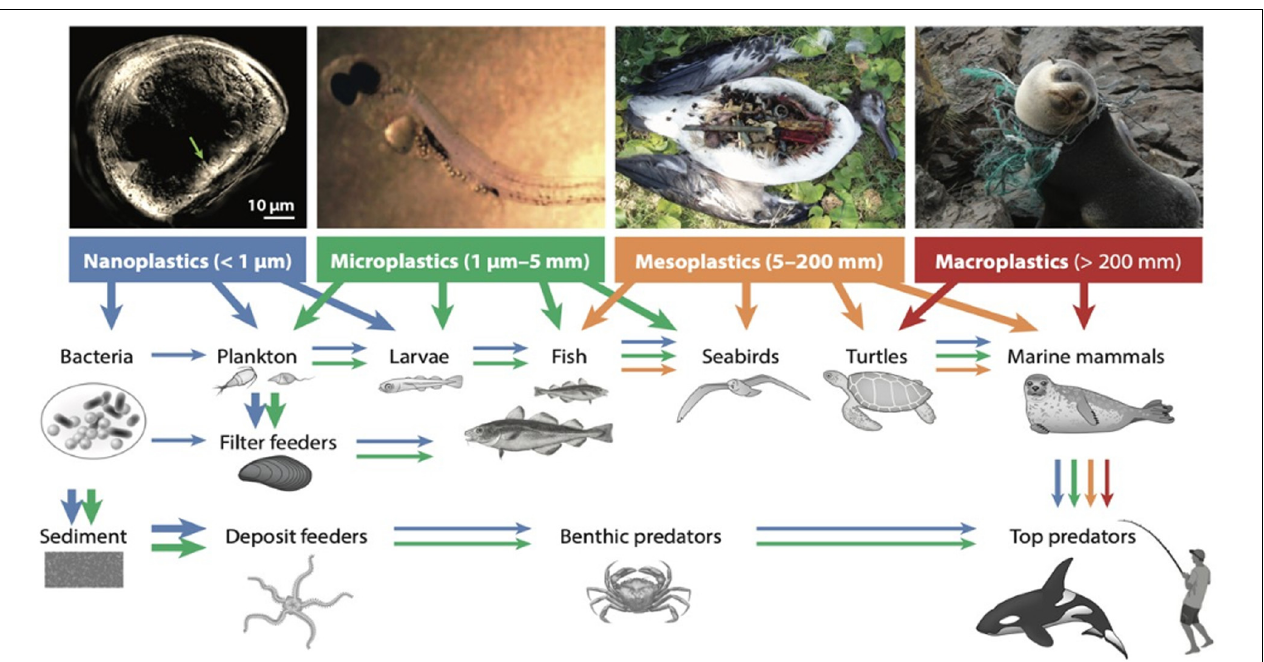
FIGURE 3 | Uptake and trophic transfer of plastic pollution in marine food chain. Plastic debris of different size categories have been shown to affect species directly by ingestion or entanglement ( thick arrows ) or indirectly via uptake of food sources ( thin arrows ). Fauna of different sizes and trophic positions will be exposed to particles of s sizes ( blue to red ) with some degree of bioaccumulation expected, for both particles themselves and associated chemical pollutants. Photographs depict ( left to right ) nanoplastic particles taken up by oyster larvae, microplastic beads ingested by European perch, dead albatross chick with micro- and mesoplastic debris in the stomach, and sea lion entangled in macroplastic fishing gear (Worm et al., 2017). Reproduced with permission from the Annual Review of Environment and Resources, Volume 42 © 2017 by Annual Reviews, http://www.annualreviews.org. Copyright 2017, Annual Review of Environment and